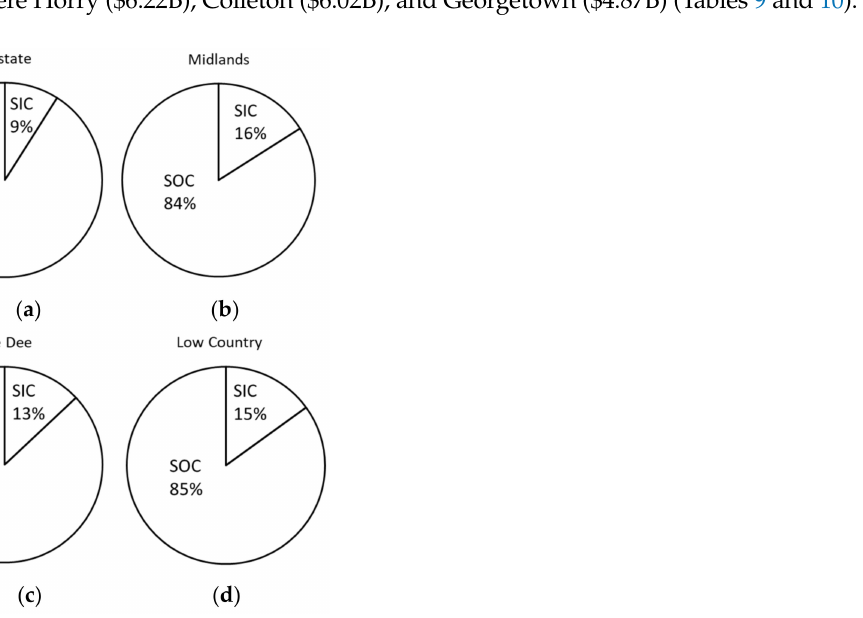
Figure 3. Distribution of soil carbon by region in the state of South Carolina: ( a ) Upstate, ( b ) Midlands, ( c ) Pee Dee, and ( d ) Low